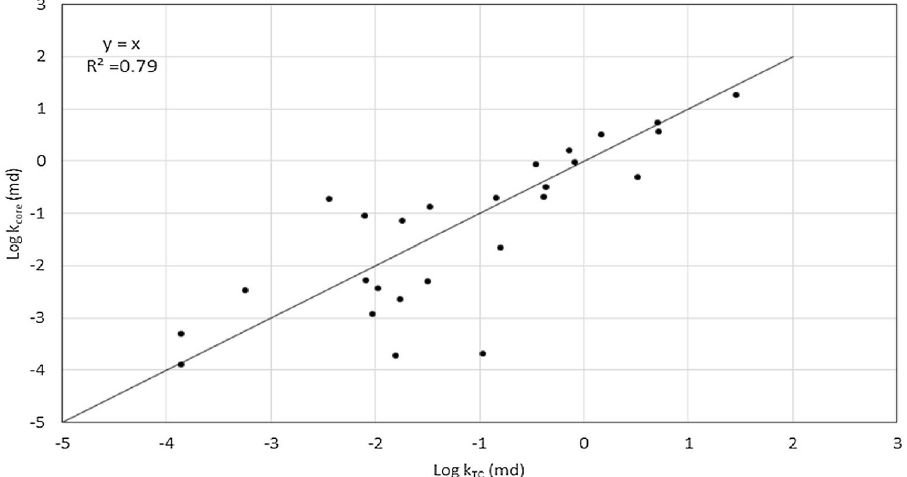
Fig. 7 Correlation of estimated permeability by TC model and core permeability ( m = 4, n =